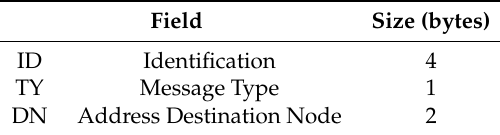
Table 4. Confirmation messages (CnfMs)